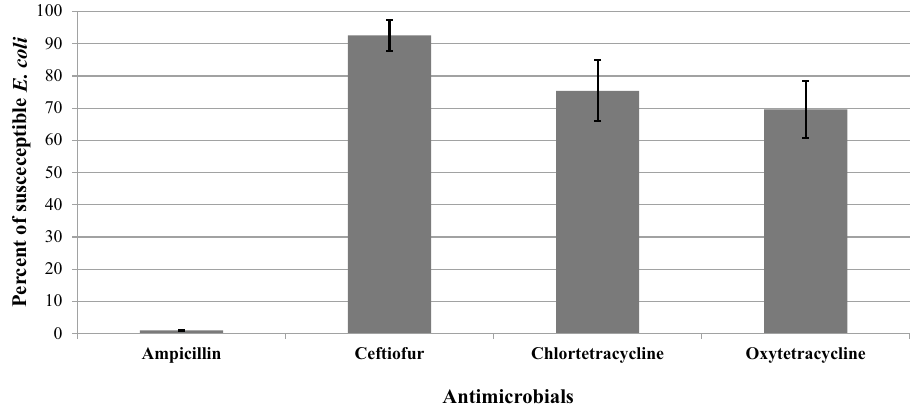
Figure 3. Percent of E. coli isolates susceptible to commonly used antimicrobial treatments for metritis. Current Clinical Laboratory Standard Institute veterinary breakpoints were used to define susceptibility 14 . A total of